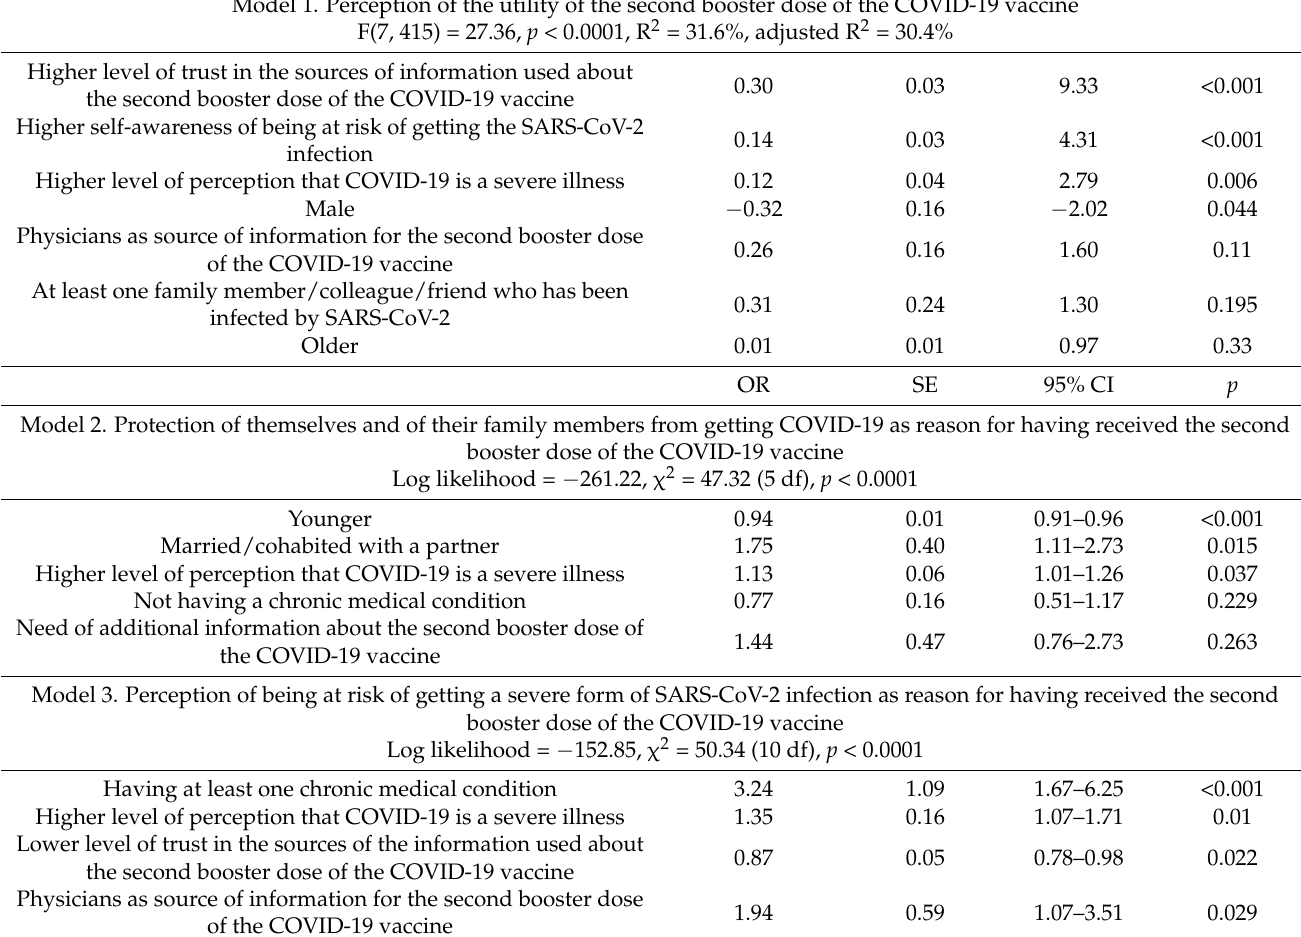
Table 2. Multivariable linear and logistic regression models for the identification of the predictors for the different outcomes of interest. Variable ß Coeff. SE t p Model 1. Perception of the utility of the second booster dose of the COVID-19 vaccine F(7, 415) = 27.36, p < 0.0001, R 2 = 31.6%, adjusted R 2 =